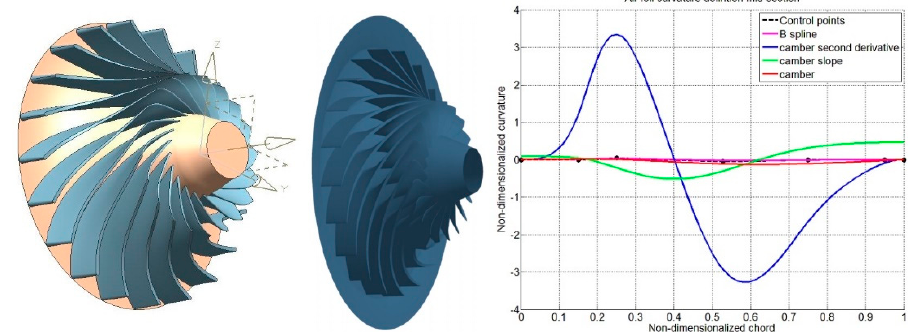
Figure 25. Centrifugal compressor design with curvature B ‐ spline at midspan of S ‐ shaped airfoil.